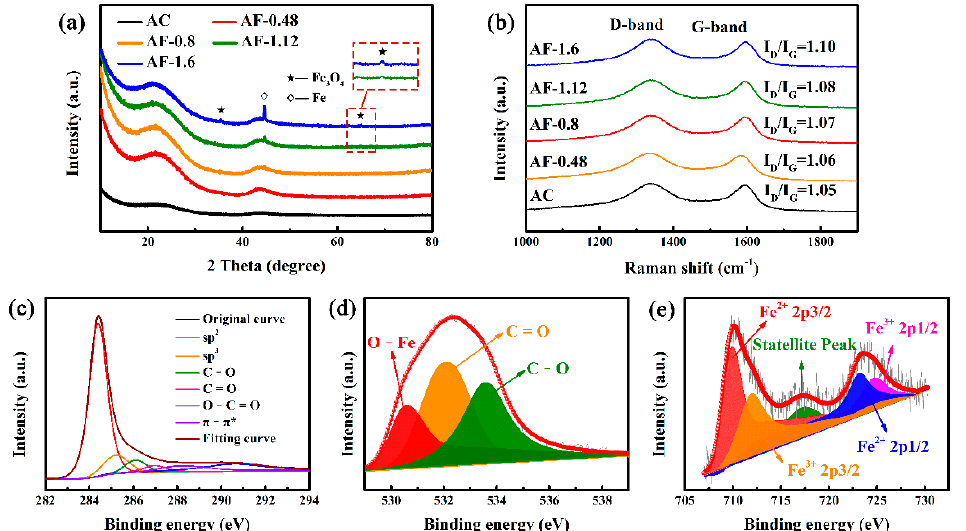
Figure 2. ( a ) XRD patterns and ( b ) Raman spectra of AC and Fe@C composites; high resolution XPS survey of AF-1.12: ( c ) C 1s, ( d ) O 1s, and ( e ) Fe 2p.